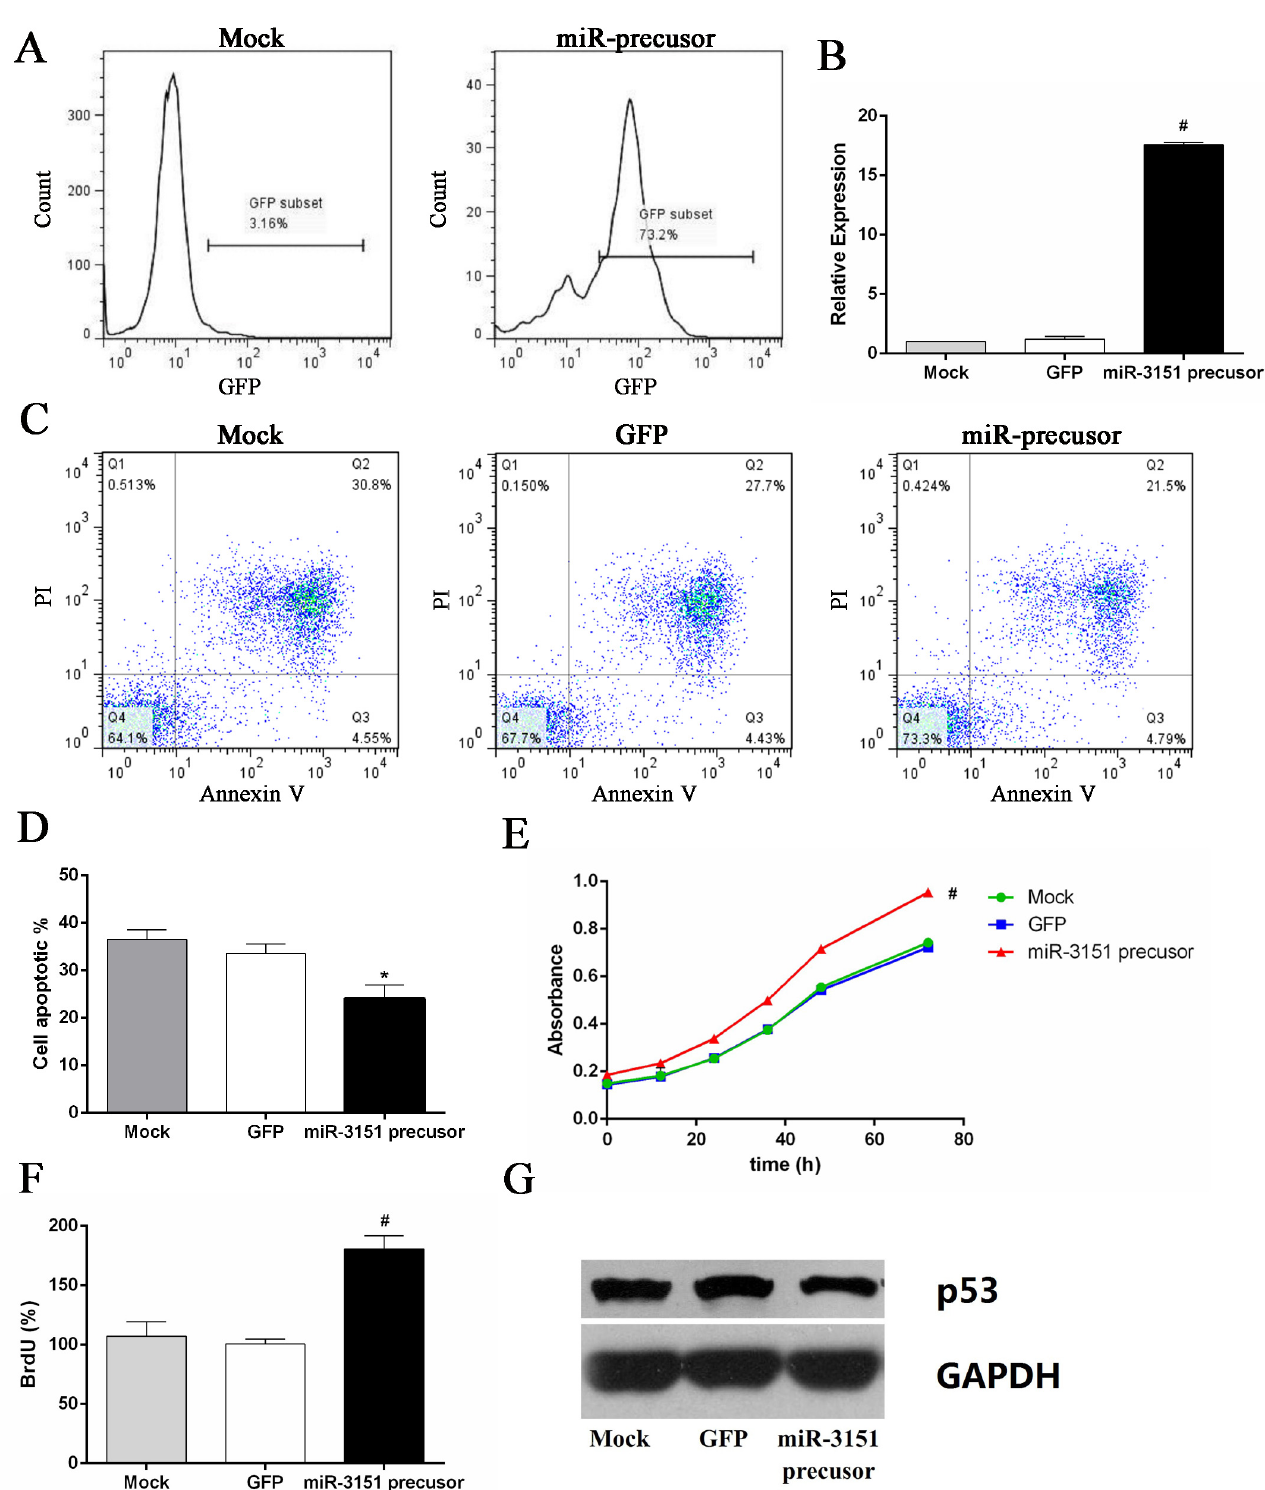
Fig 7. Overexpression of miR-3151 promoted cell proliferation and inhibition of p53 protein expression. (A) The positive rate of GFP in miR-3151 precusor group cells. (B) miR-3151 relative expression level after transfection. (C) Annexin V/PI double-staining flow cytometry of SKM-1 cells overexpressing miR-3151 treated with 46.20 nM HHT and 4.46 nM Bortezomib. (D) Overexpressing miR-3151 of SKM-1 cells partly reversed the effect of HHT and Bortezomib. (E) The cell viability of SKM-1 cells overexpressing miR-3151. (F) The cell proliferation of SKM-1 cells overexpressing miR-3151. (G) p53 protein level in SKM-1 cells overexpressing miR-3151. * P < 0.05, #P < 0.01 vs mock group.